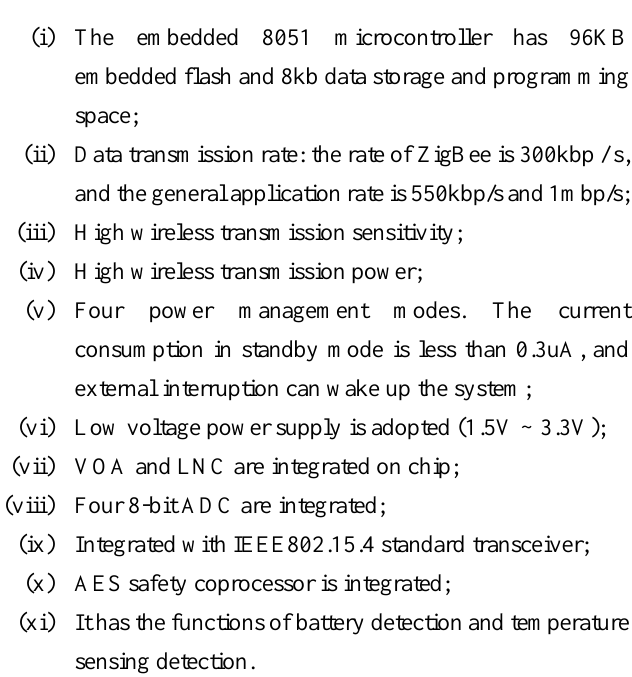
Figure 2. Wireless sensor network